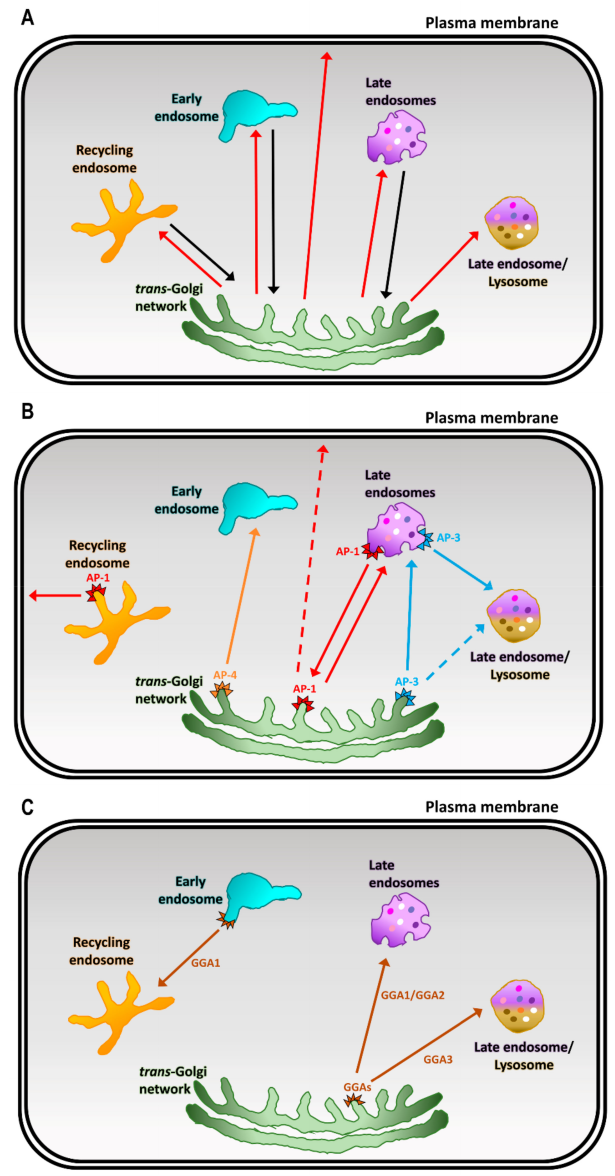
Figure 1. Membrane tra ffi cking pathways at the trans -Golgi network (TGN): ( A ) a schematic showing the post-Golgi tra ffi cking pathways (red arrows) and the retrograde recycling pathways (black arrows) from the plasma membrane and endosomal / lysosomal compartments back to the TGN; ( B ) the distinct tra ffi cking pathways at the TGN are regulated by specific cargo adaptor proteins including adaptor protein (AP) complexes (AP-1 in red, AP-3 in blue, AP-4 in orange); and ( C ) monomeric Golgi-localized, γ ear-containing, Arf-binding proteins (GGA1-3 in